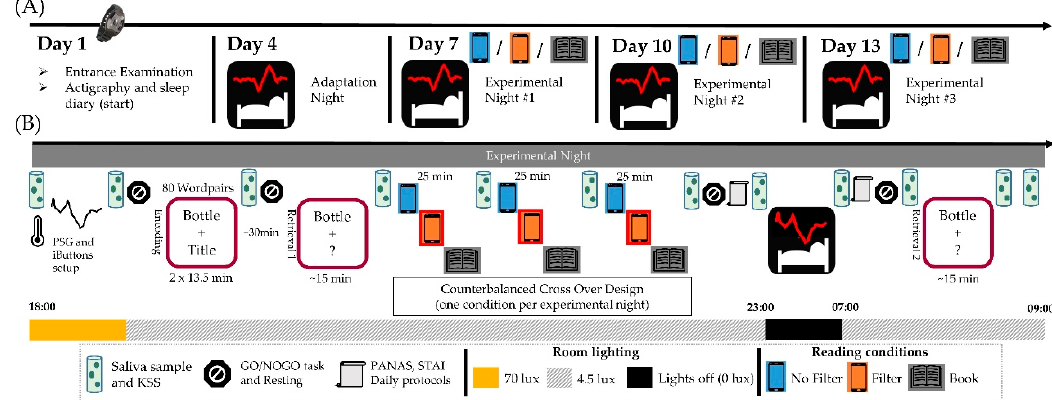
Figure 8. Overview of the study design. ( A ): Outline of the general procedure and the days on which participants had to come to the laboratory. ( B ): Detailed procedure for the experimental nights. Subjects wore wrist actigraphy and completed sleep diaries for the whole study period.